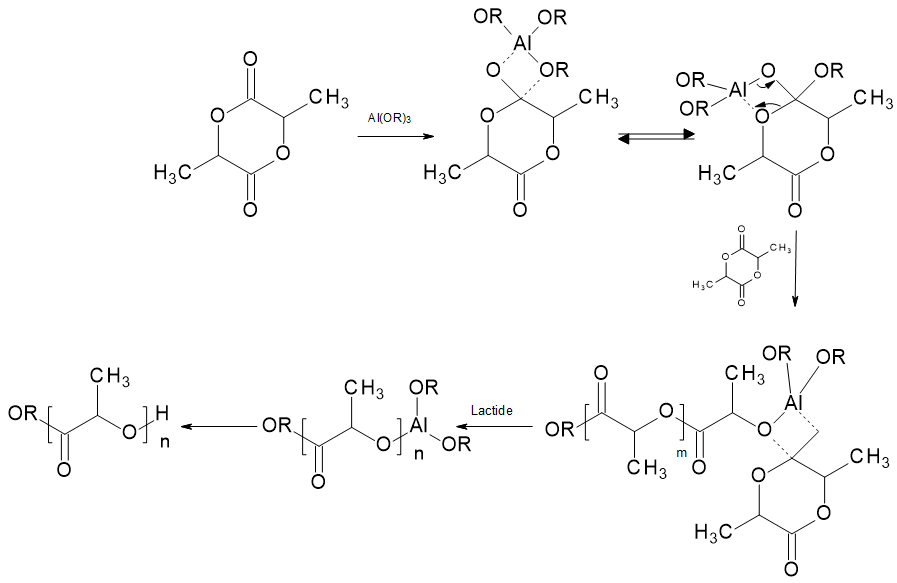
Figure 12. Coordinative ring-opening polymerization mechanism for PLA [5].